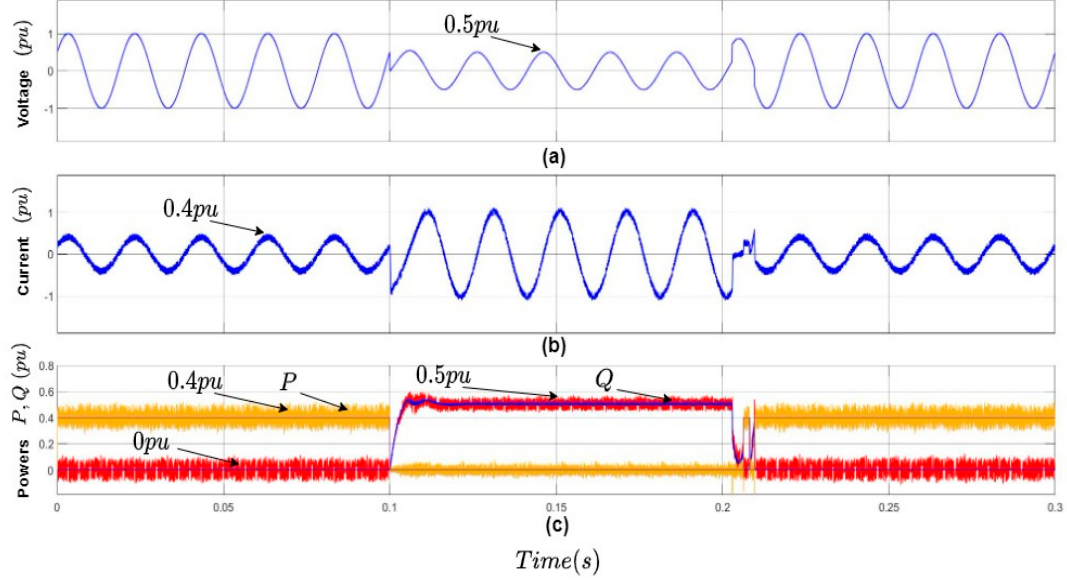
Figure 14. Solar-PV system injecting reactive power during a voltage sag; ( a ) voltage, ( b ) current, ( c ) power.